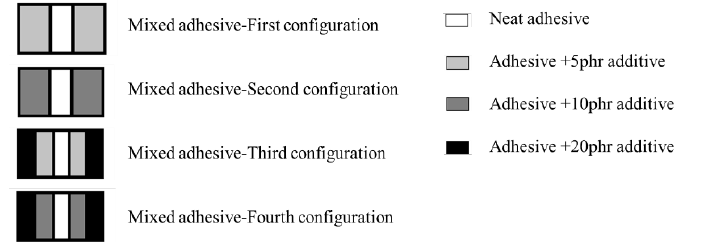
Figure 12. Schematic design of mixed adhesive joint studied by Dadian and Rahnama [105].